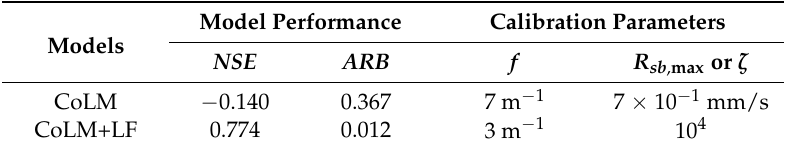
Figure 8. Comparison of daily time series of model simulated specific discharges of total runoff from the baseline CoLM and the new CoLM+LF under each calibrated parameter set, along with the daily observations from the Jindong stream gauge station in the study watershed during 2009. The observed hyetographs of total precipitation averaged for the study watershed are presented along the secondary vertical axis. Table 1. Comparison of the model performance measured by the Nash–Sutcliffe coefficient, NSE and the absolute relative bias, ARB for daily runoff results in the study watershed during 2009 simulated from the baseline CoLM under the calibrated values of the hydraulic conductivity decay factor f and the maximum baseflow coefficient R sb,max and from the new CoLM+LF under the calibrated values of the hydraulic conductivity decay factor f and the hydraulic conductivity anisotropic ratio ζ